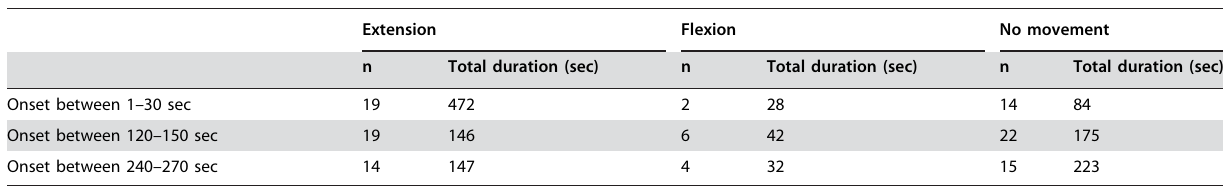
Frequency and total duration of movement illusions and silent periods in Run 1 is shown as a function of the time of the onset of the event. ‘Onset’ indicates the time of onset of the event relative to the moment when vibration started (the whole duration of the event was measured, regardless of whether it finished within the 30 sec period or not). Note that extension responses initially dominated but were later replaced by the increasingly longer ‘no movement’ periods and, to a lesser extent, flexion responses.